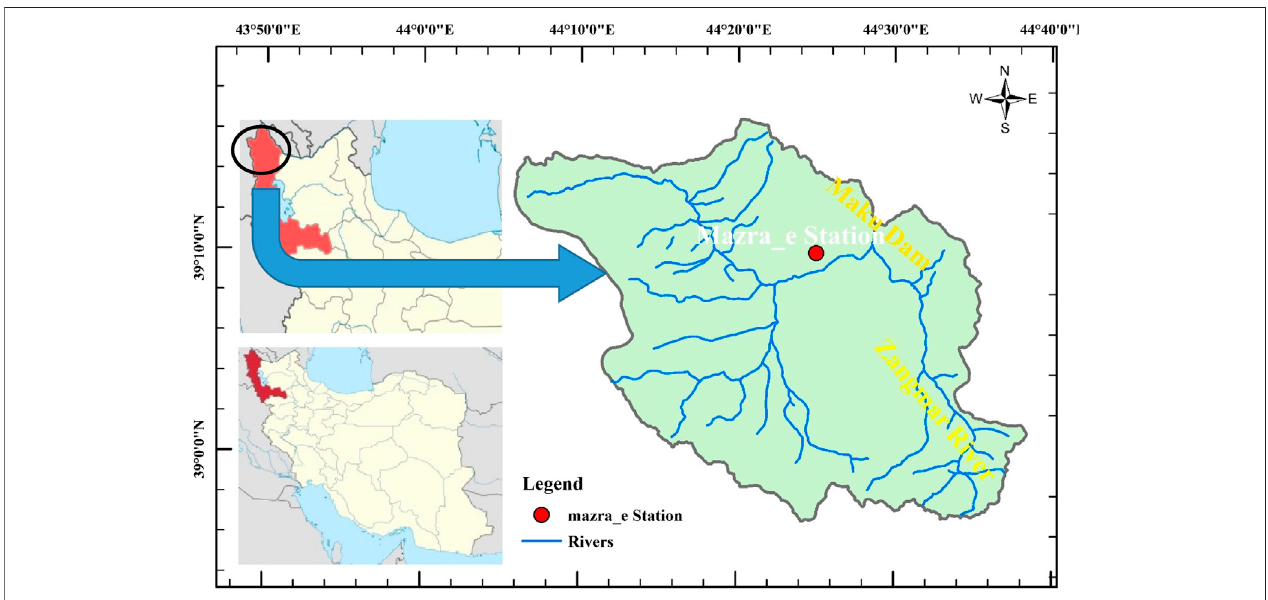
FIGURE 1 | The study area of Maku